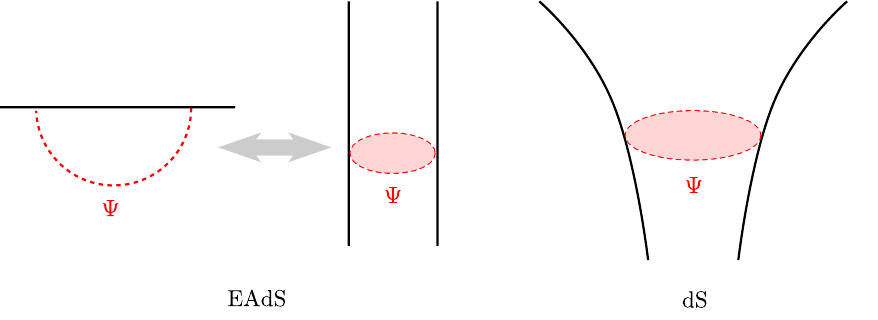
JHEP03(2022)023